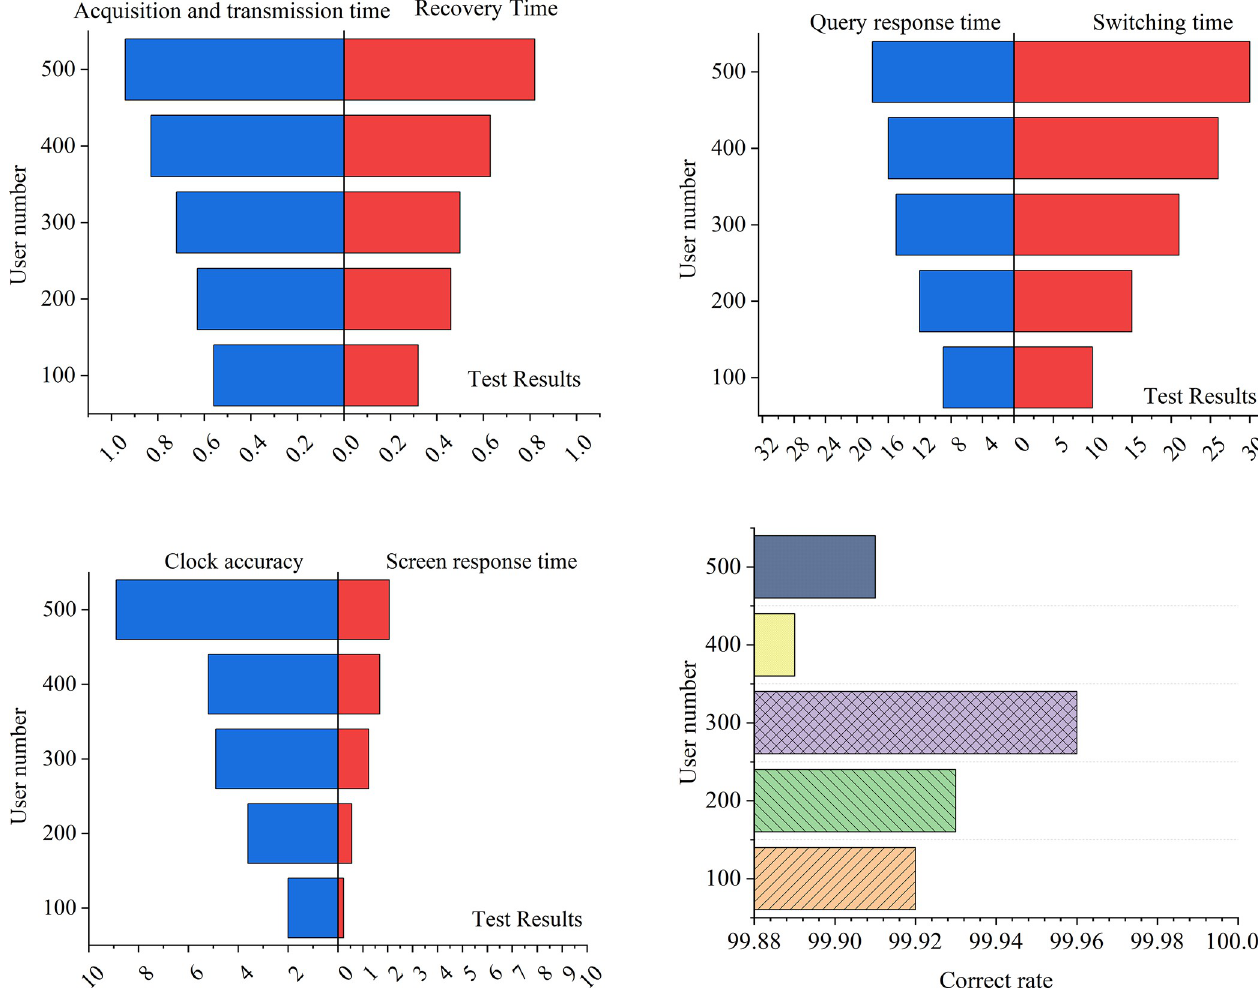
Fig 13. Data results for other performance test of the system.